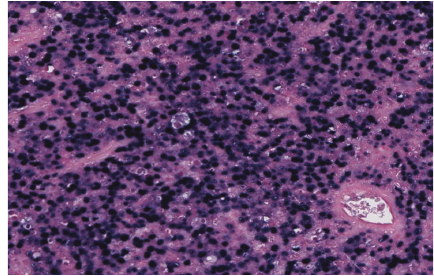
Figure 4: Epstein Barr Virus EBER staining in BBL.